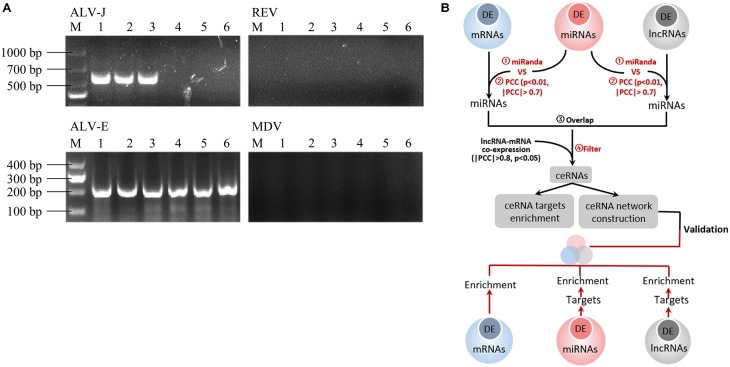
(A) Routine PCR and agarose gel electrophoresis for the detection of ALV-J, ALV-E, MDV, and REV. Lanes 1–3: spleen tissues from suspected ALV-J infected chickens; lanes 4–6: spleen tissues from ALV-J uninfected chickens. Lane M, DNA marker. Agarose gel electrophoresis showed a 545 bp amplicon specific to ALV-J in lines 1–3 and a 197 bp amplicon specific to ALV-J in all lines, and there is no amplicons specific to MDV and REV. (B) Flow-chat of the study design.